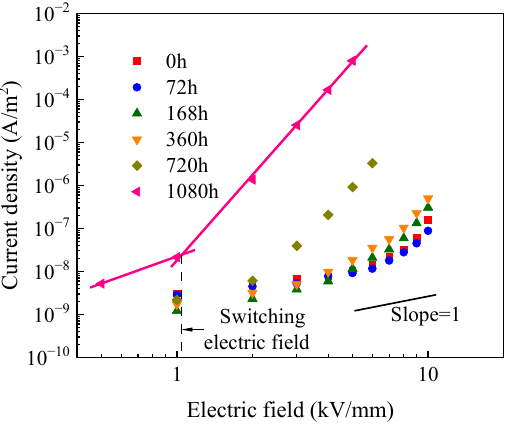
Figure 4. Relationship between current density and electric field strength of aged SiC/epoxy micro- composites under different ageing time. Table 1. Nonlinear coefficient and switching electric field of aged SiC/epoxy micro-composites. Ageing Time